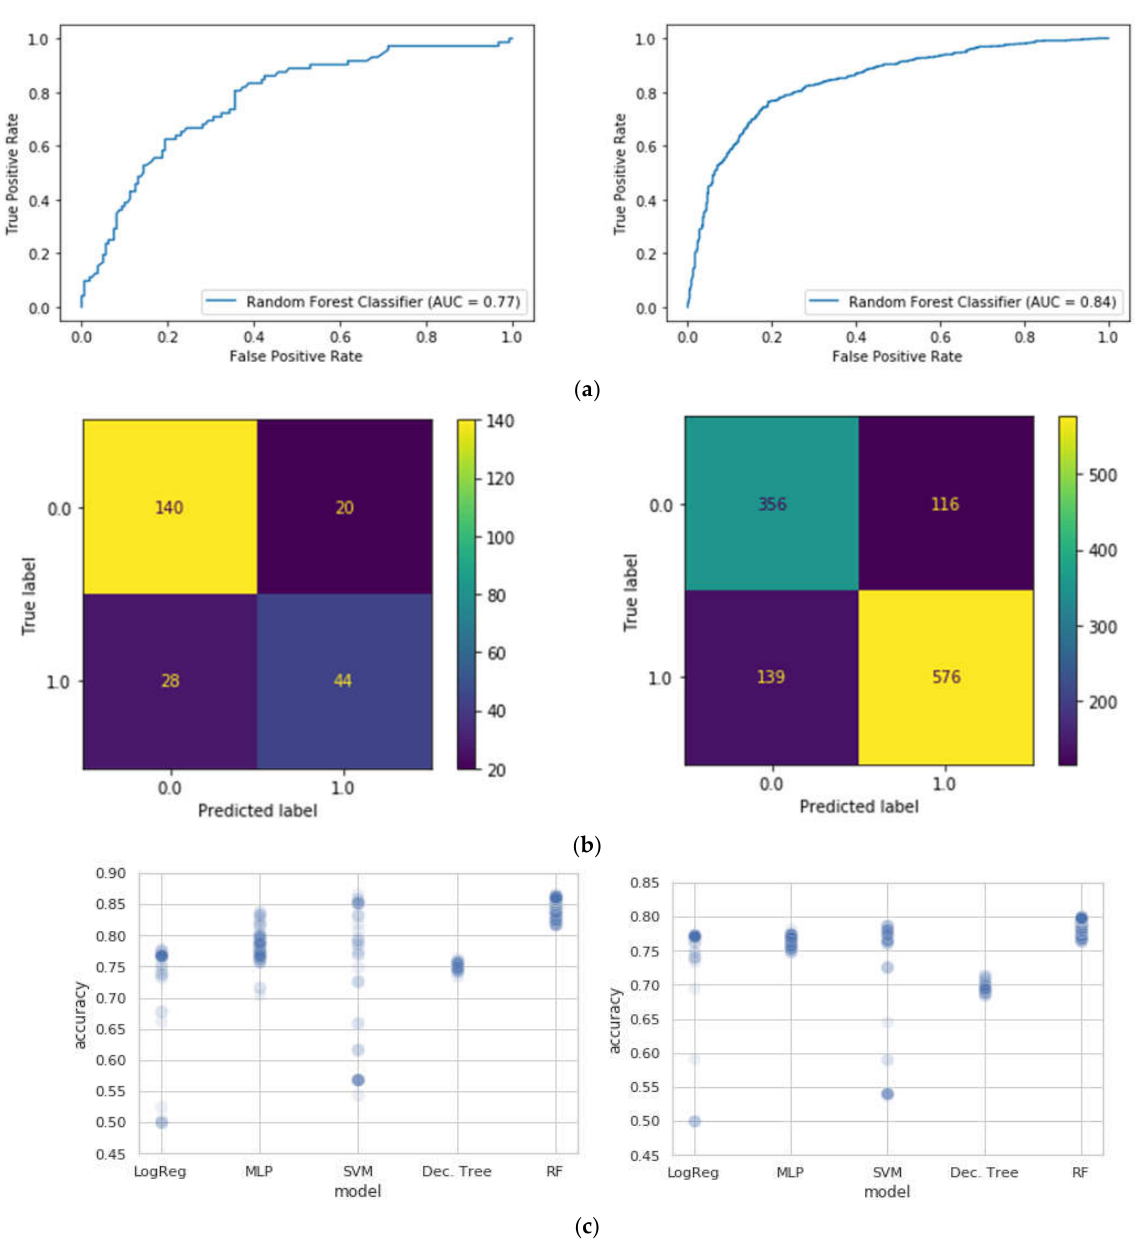
Figure 2. ( a ) Area under the ROC curve (AUC) indicators for the private (left) and public (right) school participants. AUC score indicates how well separated are the classes 0 and 1 in the Random Forest classifier. ( b ) Confusion matrix for the Random Forest Classifier model for the private (left) and public (right) school participants. ( c ) a cursory look at the accuracy of the different ML models in the exhaustive search for best hyperparameters for the private (left) and public (right) school participants. Note that RF performs better than other ML models in terms of performance consistency regardless of the hyperparameters.